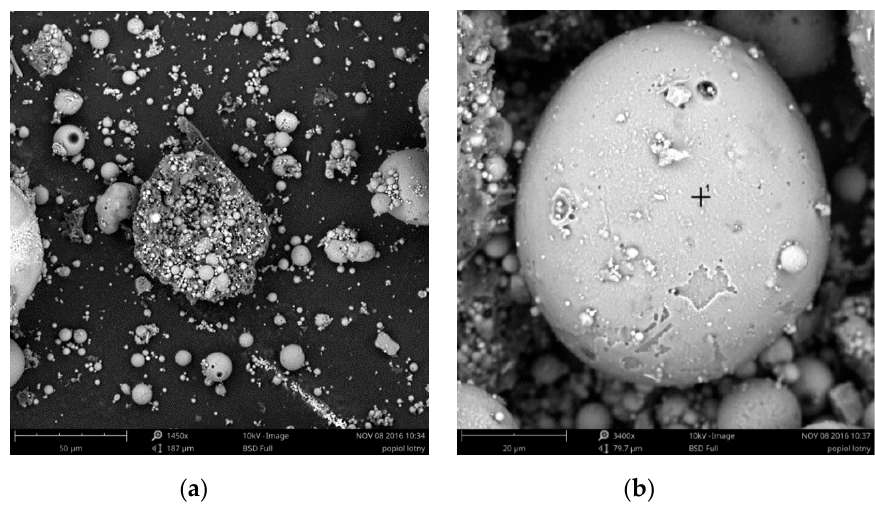
Figure 3. SEM images of fly ash: ( a ) magnification of 1400×, ( b ) magnification of 3400×.